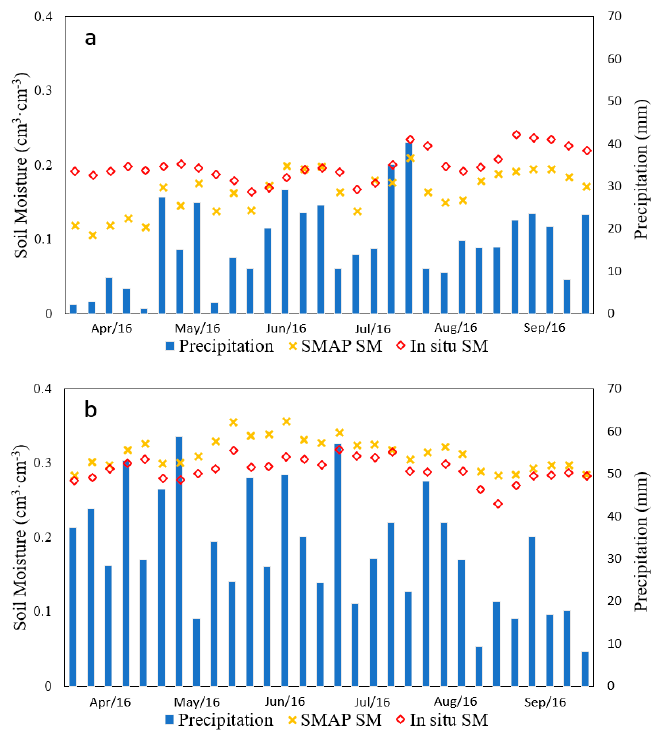
Figure 5. Custom regions in China for the evaluation of the SMAP L3 radiometer SM at the regional scale, including region 1–3.